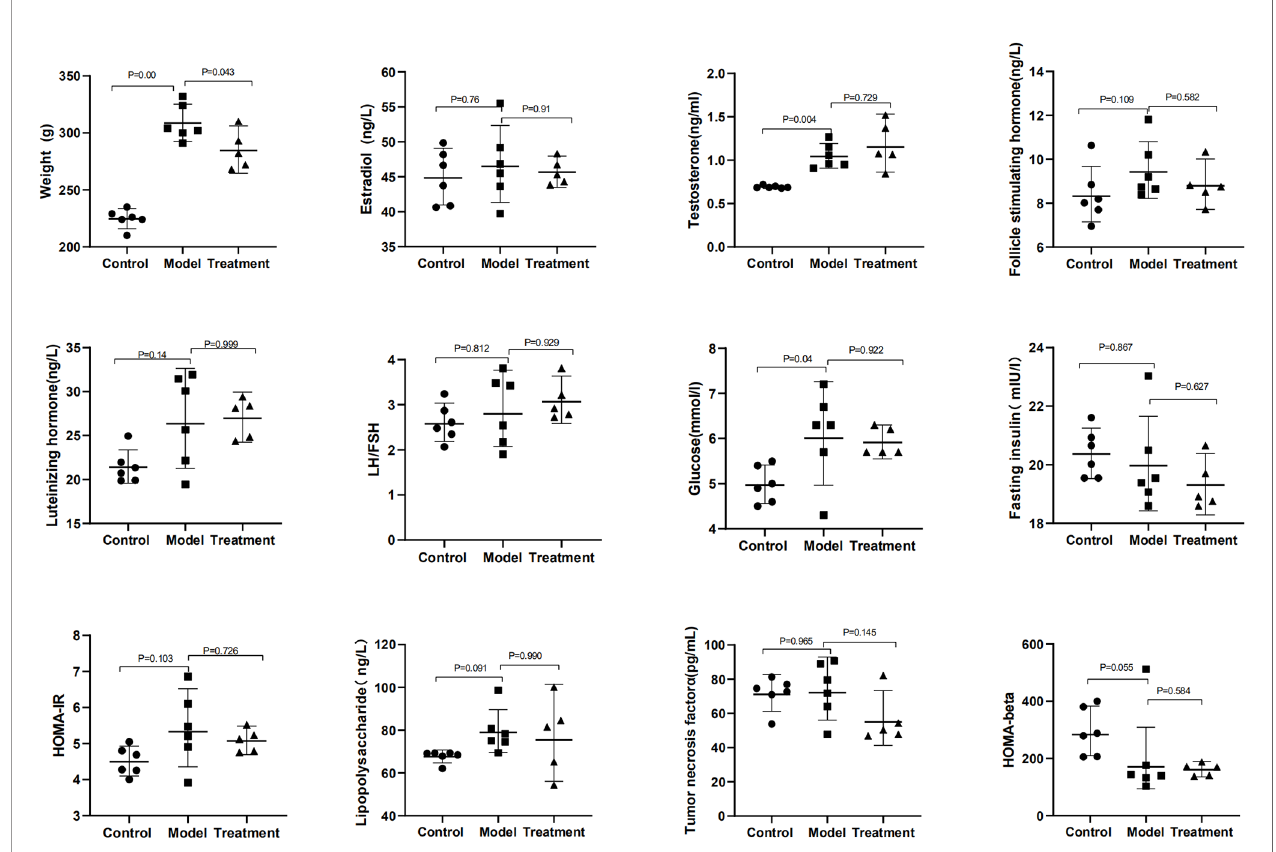
FIGURE 1 | Characteristics of reproductive hormones, glucose metabolism, and in fl ammatory